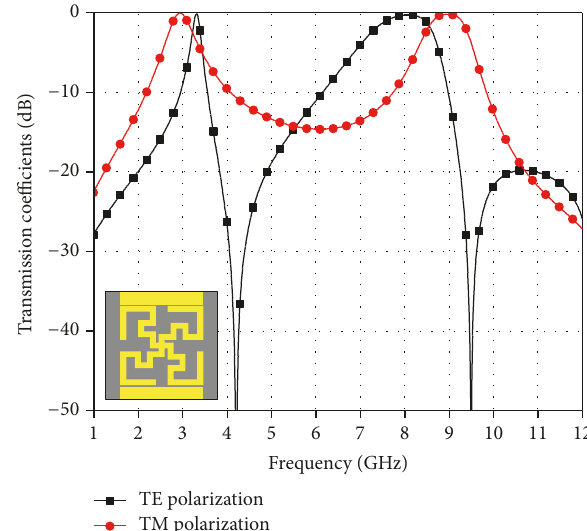
Figure 6: Transmission coefficients of the dual-band FSS with the different length of slots.